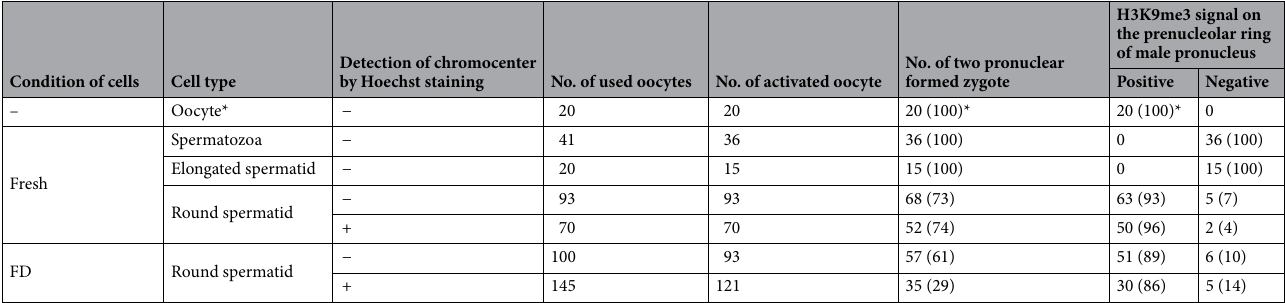
Table 2. Detection of H3K9me3 in the male pronucleus of zygote fertilized with different stages of germ cells with or without confirmation of chromocenter before ROSI. *Oocyte were parthenogenetically activated and female pronucleus were observed as control.